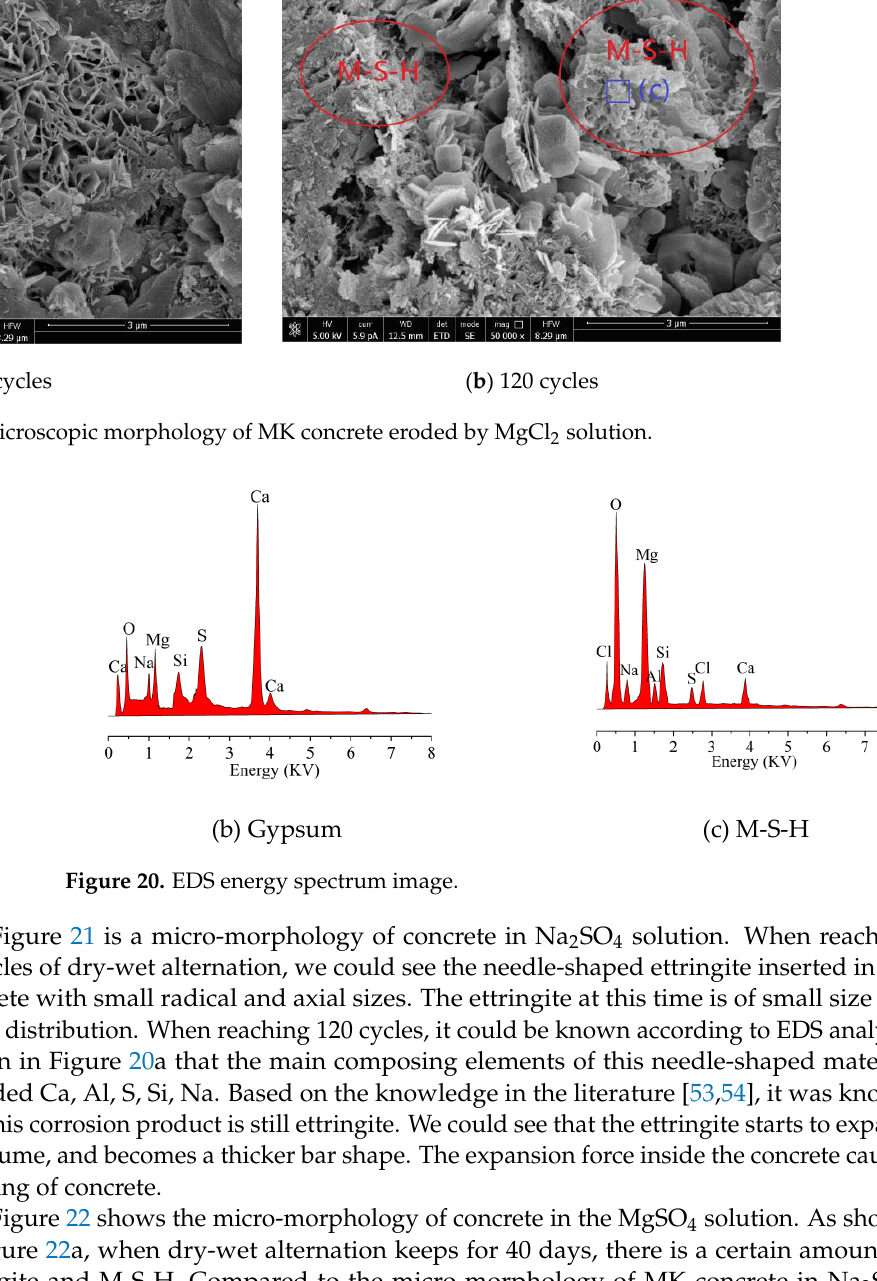
Figure 21. Microscopic morphology of MK concrete eroded by Na 2 SO 4 solution.